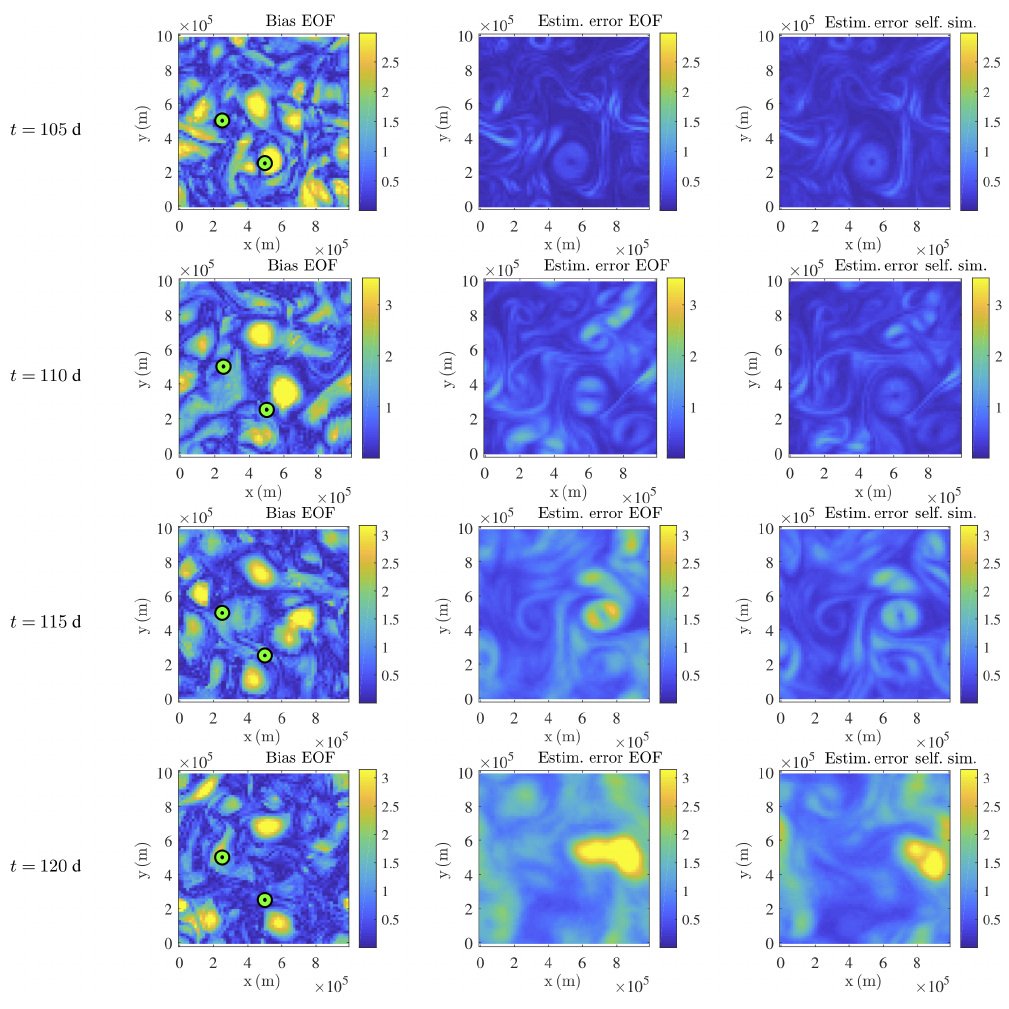
Figure 12. Normalized buoyancy bias absolute value, | (cid:98) E { b }− b ref | , (dimensionless) of the stochastic SQG model (left) and its estimation (1.96 times the standard deviation of the ensemble) for the data-driven method (middle) and the self-similar one (right) at a resolution of 64 2 at (from top to bottom) t = 105, 110, 115, and 120d. The reference is the usual SQG model at a resolution of 512 2 , adequately filtered and subsampled. The stochastic simulations and the reference have a common initial condition at t = 100d. Points used for the local UQ analysis of Figs. 13 and 14 are highlighted in green.